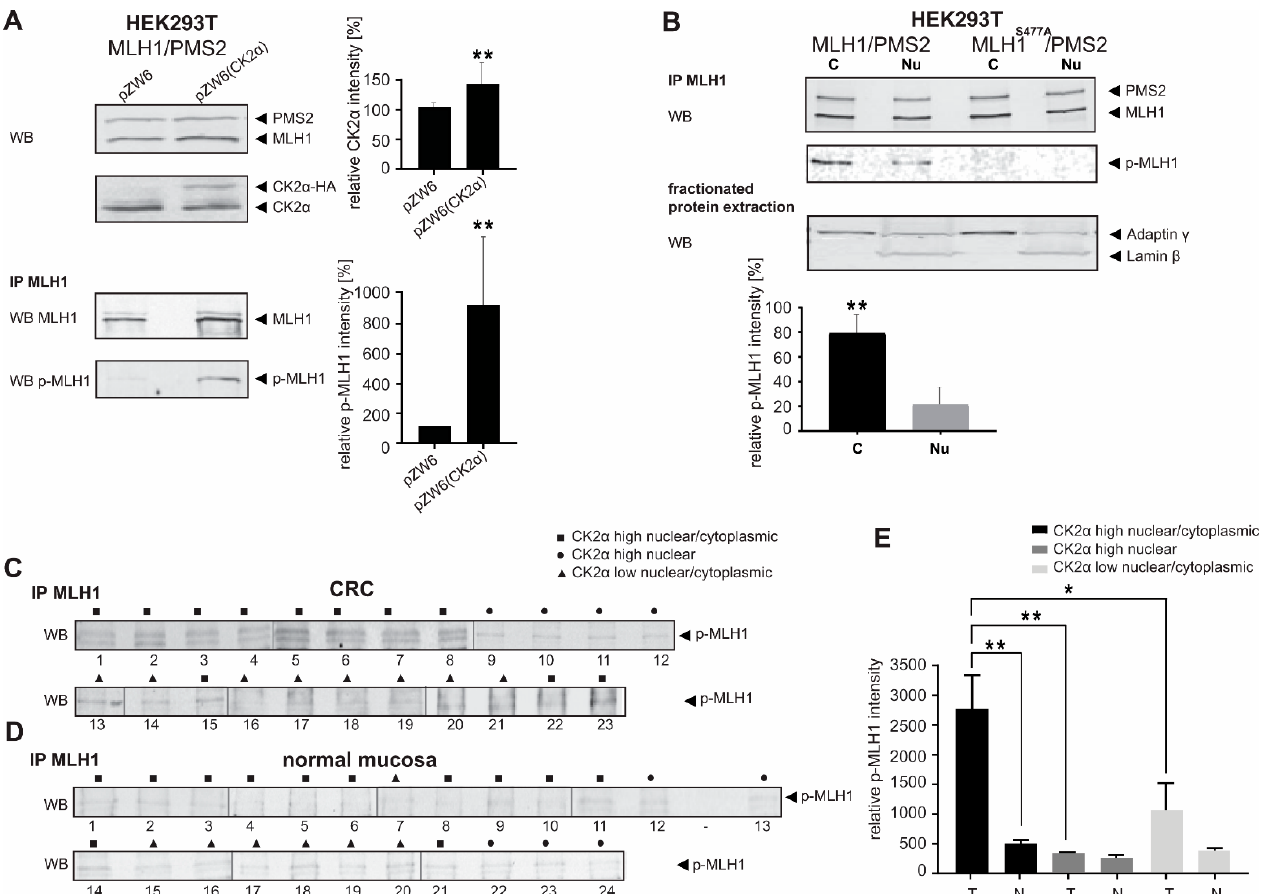
Figure 4. Enhanced p-MLH1 S477 levels in CRC are associated with high nuclear/cytoplasmic CK2 α expression. Protein extracts were isolated from ( A ) transiently pcDNA3.1+/MLH1, pcDNA3.1+/PMS2 and pZW6(CK2 α ), or empty pZW6 cotransfected HEK293T cells, ( B ) cytoplasmic and nuclear frac- tions of transiently pcDNA3.1+/MLH1 and pcDNA3.1+/PMS2 or pcDNA3.1+/MLH1 S477A and pcDNA3.1+/PMS2 cotransfected HEK293T cells, ( C ) FFPE CRC tissue, and ( D ) FFPE normal adjacent mucosa of high nuclear/cytoplasmic, high nuclear and low nuclear/cytoplasmic CK2 α -expressing cases. After immunoprecipitation with anti-MLH1 antibody, p-MLH1 was detected by Western blotting. p-MLH1 levels were quantified (mean ± S.D.) using the Multi Gauge V3.2 program. ( E ) Comparison of p-MLH1 levels of FFPE CRC and normal mucosa of high nuclear/cytoplasmic, high nuclear and low nuclear/cytoplasmic CK2 α -expressing cases, respectively. Statistical signifi- cance was assessed by GraphPad Prism 7 for Windows, Version 7.04 (GraphPad Software, La Jolla, CA, USA). p -values are two-sided and values <0.05 (*) or <0.001 (**) are considered